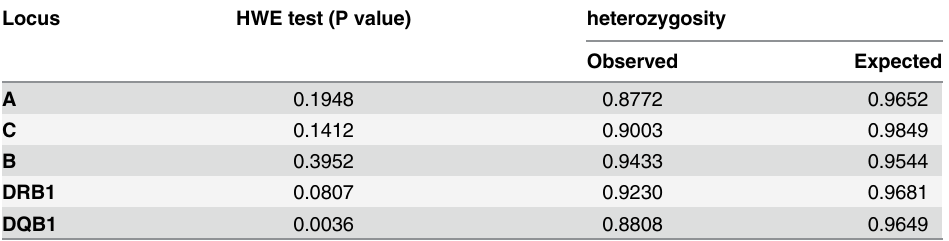
Table 2. Hardy-Weinberg equilibrium tests for the HLA-A, -C, -B, -DRB1, and -DQB1 loci in 169,995 Chinese individuals. Locus